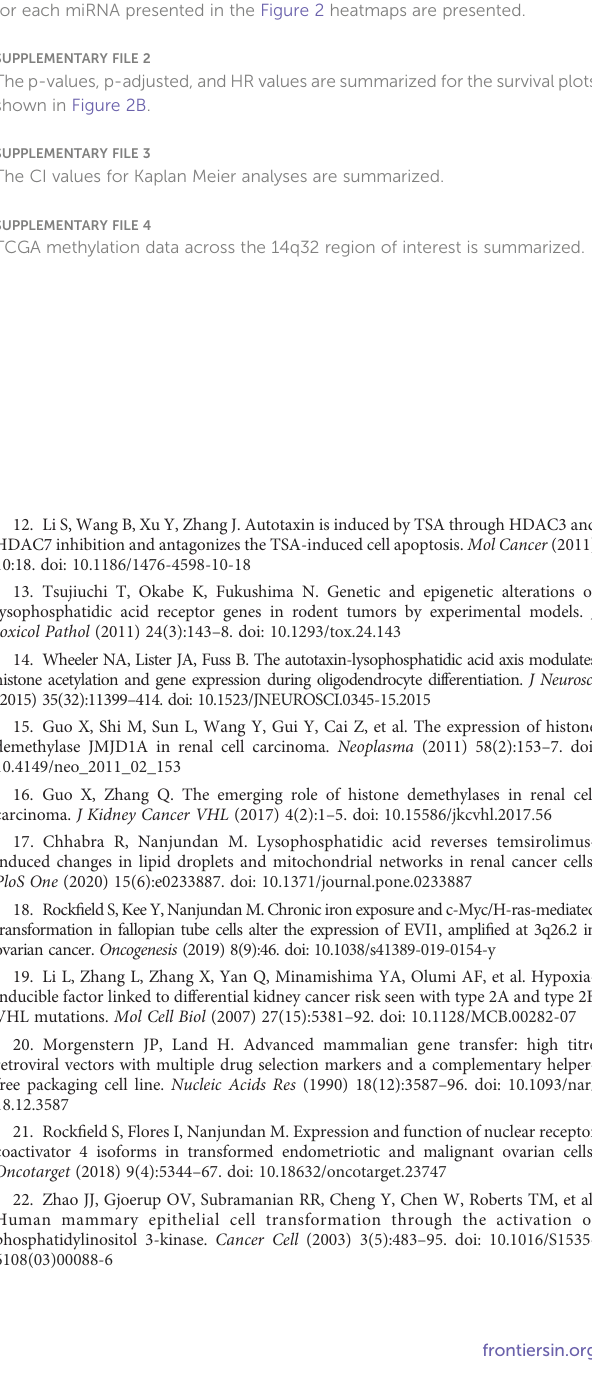
The list of total quanti fi able proteins with differential expressed proteins are